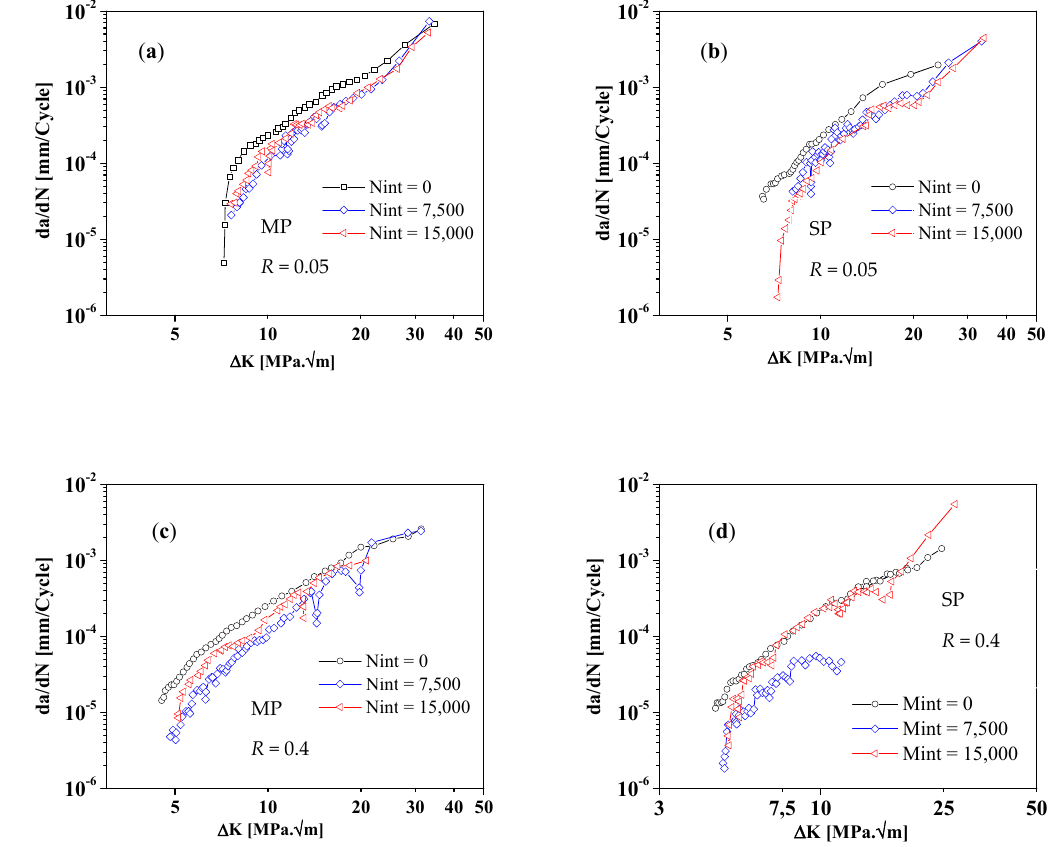
Figure 10. Block overload effect on da/dN- ∆ K curves for 8 mm thick specimens: ( a ) R = 0.05, MP; ( b ) R = 0.05, SP; ( c ) R = 0.4, MP; and ( d ) R = 0.4, SP.